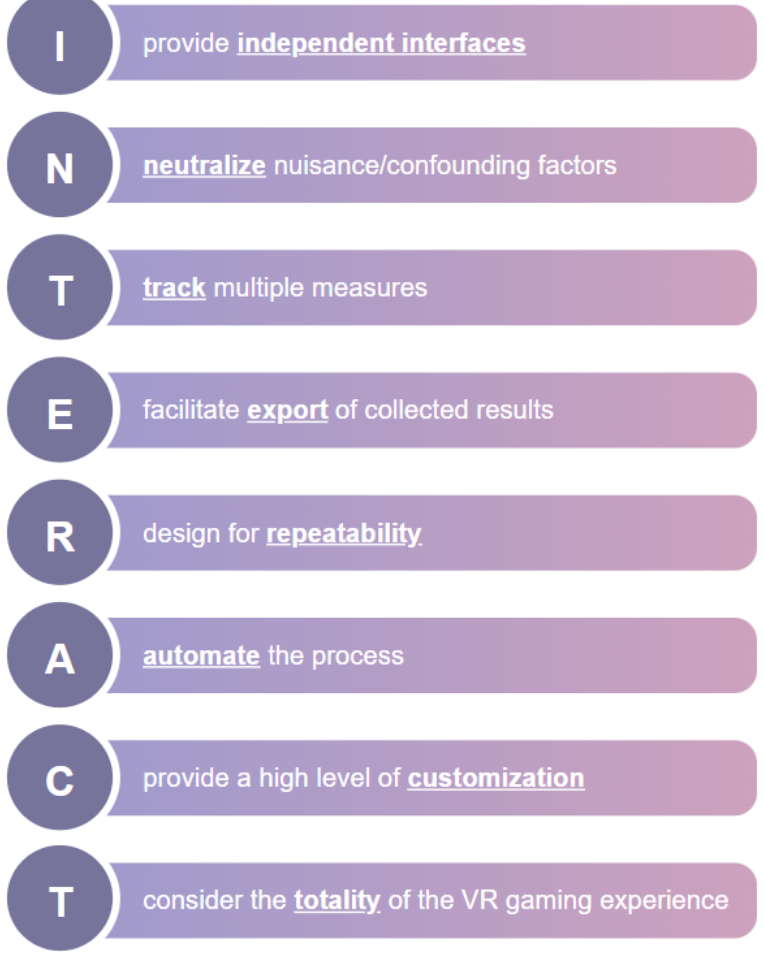
Figure 6. The INTERACT framework: designing platforms for the evaluation of the quality of VR interaction